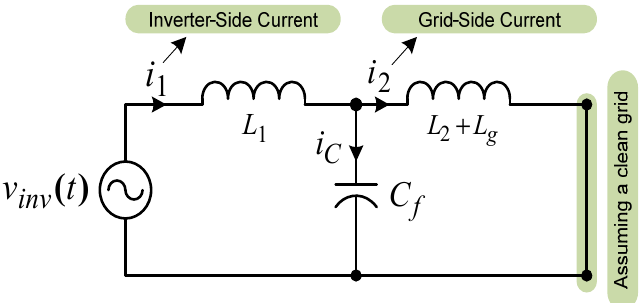
Figure 3. Per-phase equivalent circuit for stability analysis.